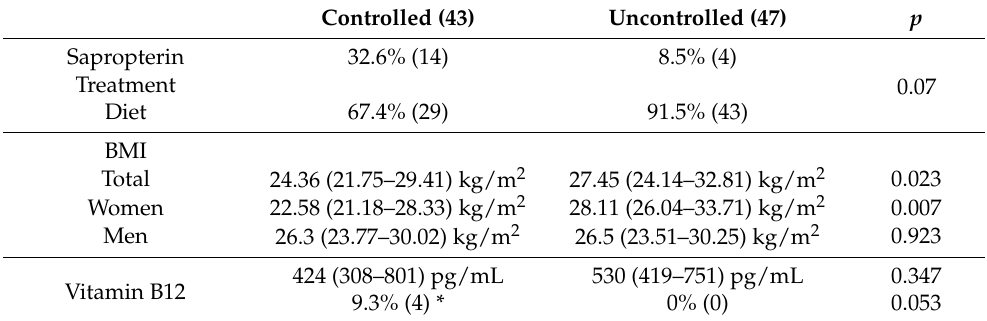
Table 3. Clinical differences between controlled and uncontrolled patients (according to Phe